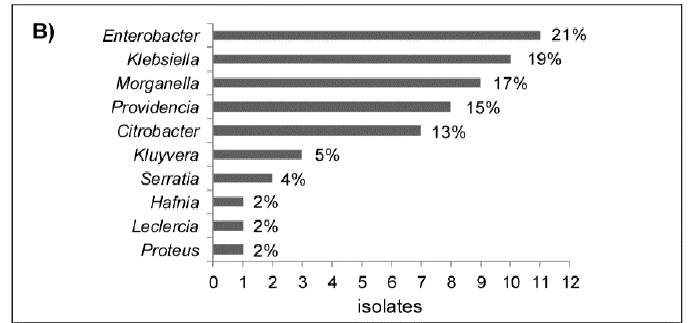
Figure 3. Percentage of cloaca-associated bacterial isolates ( n = 90) for each family ( A ) and of bacterial isolates ( n = 53) for each genus ( B ) of the Enterobacteriaceae family is reported. Eight bacterial genera were found in cloacal samples from both healthy and weak turtles, but in some cases their relative percentages varied. In particular, Shewanella sp., Enterobacter spp., Citrobacter freundii , Pseudomonas and Vibrio were equally distributed, while Klebsiella , Morganella and Providencia were more abundant in cloacal samples of healthy turtles. In contrast, Hafnia , Achromobacter , Leclercia and Proteus cibarius were found only in healthy turtles and Acinetobacter , Kluyvera intermedia and Serratia only in weak turtles (Figure 4).